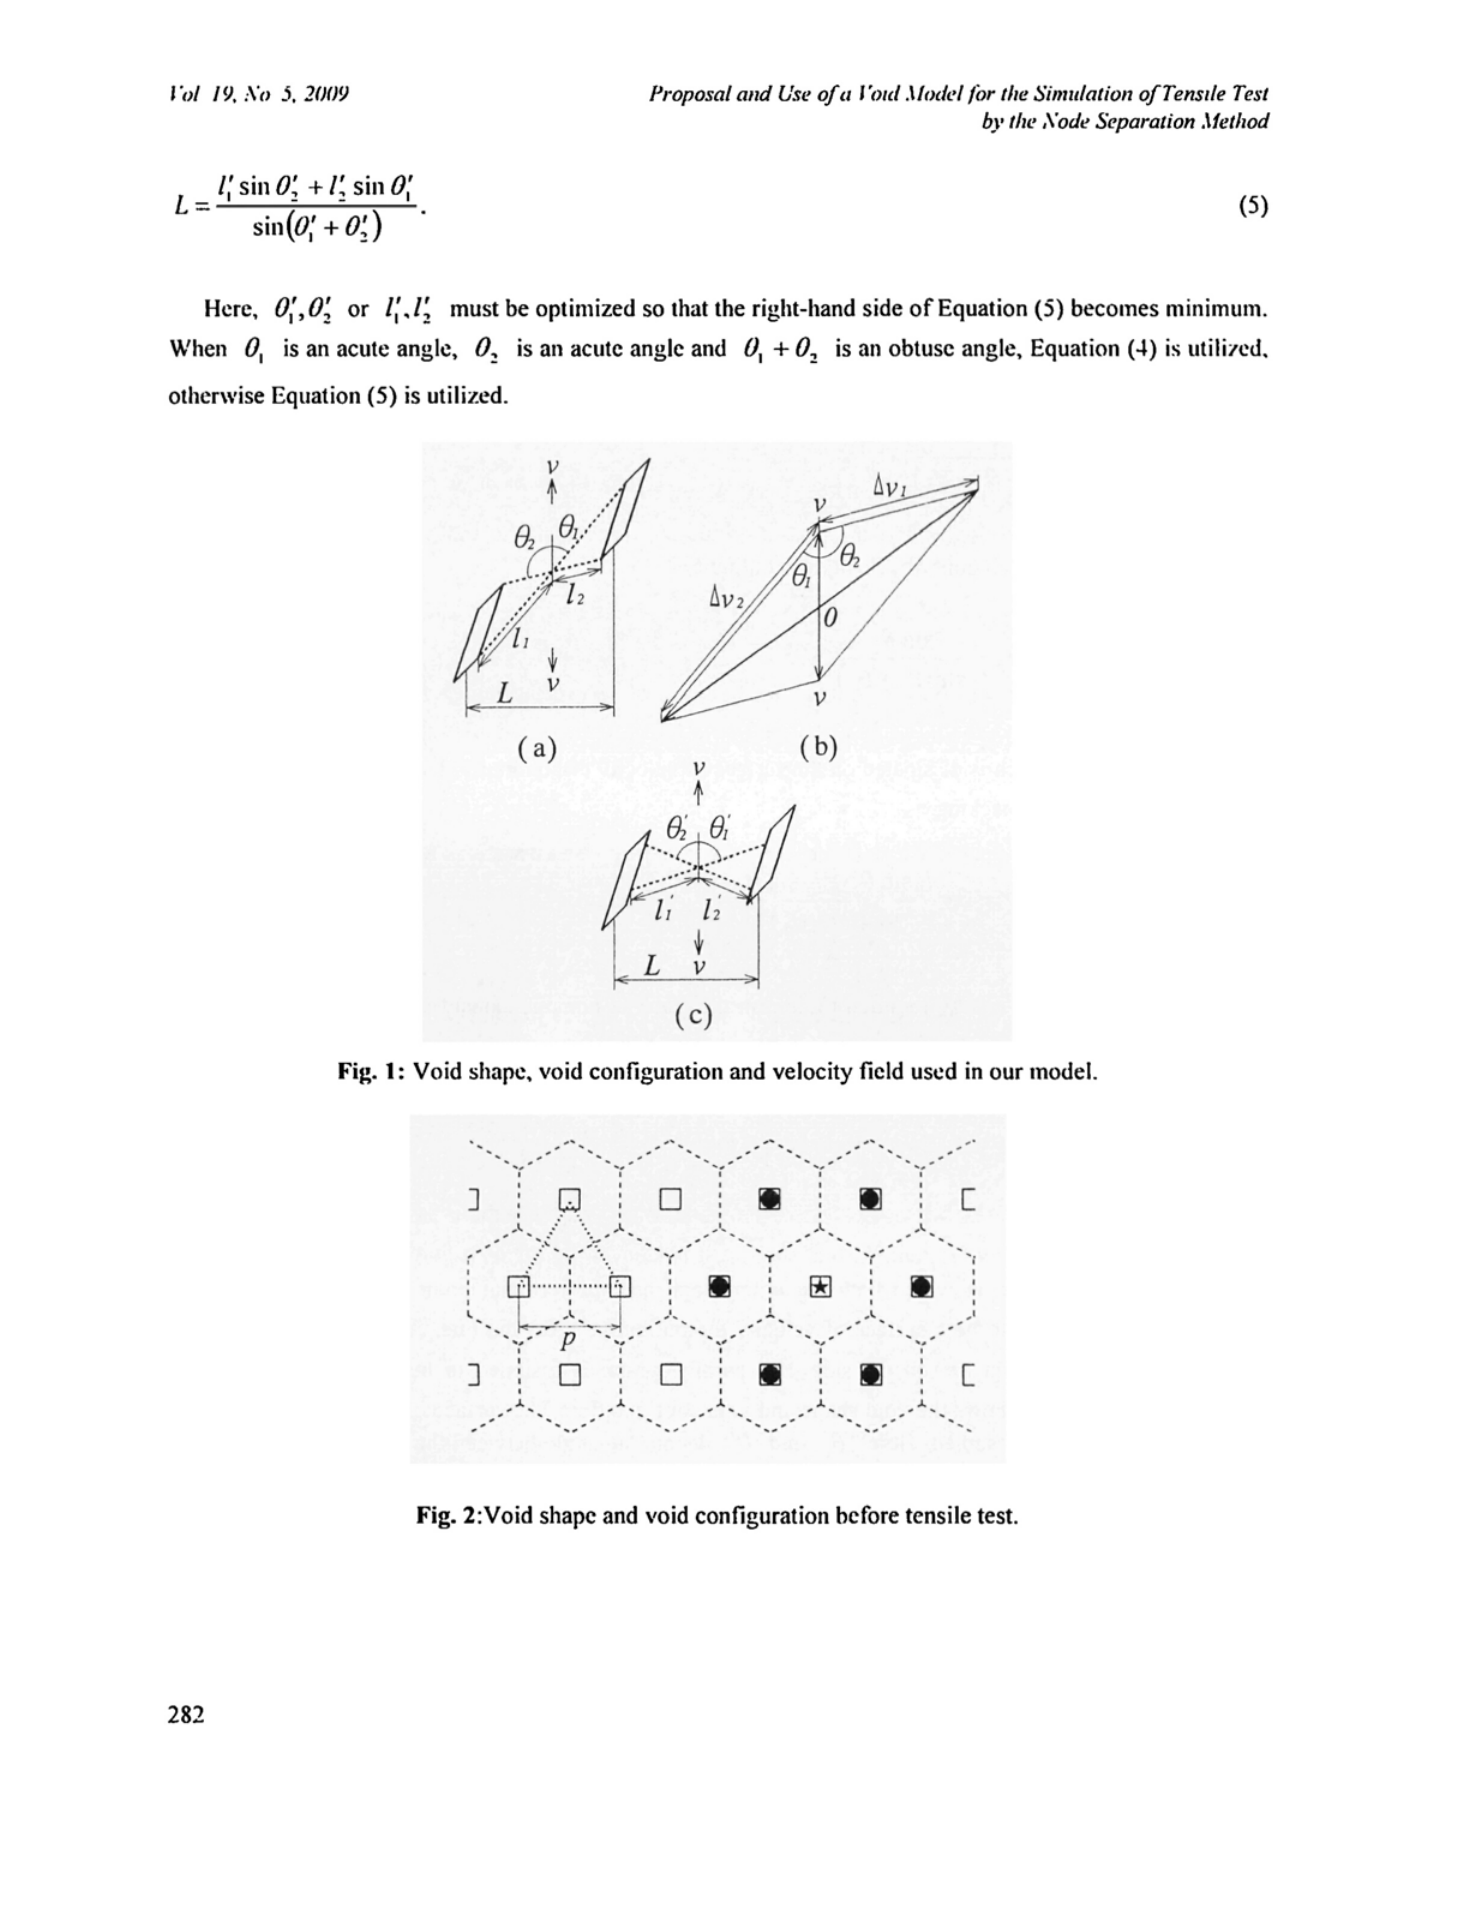
Fig. 2:Void shape and void configuration before tensile